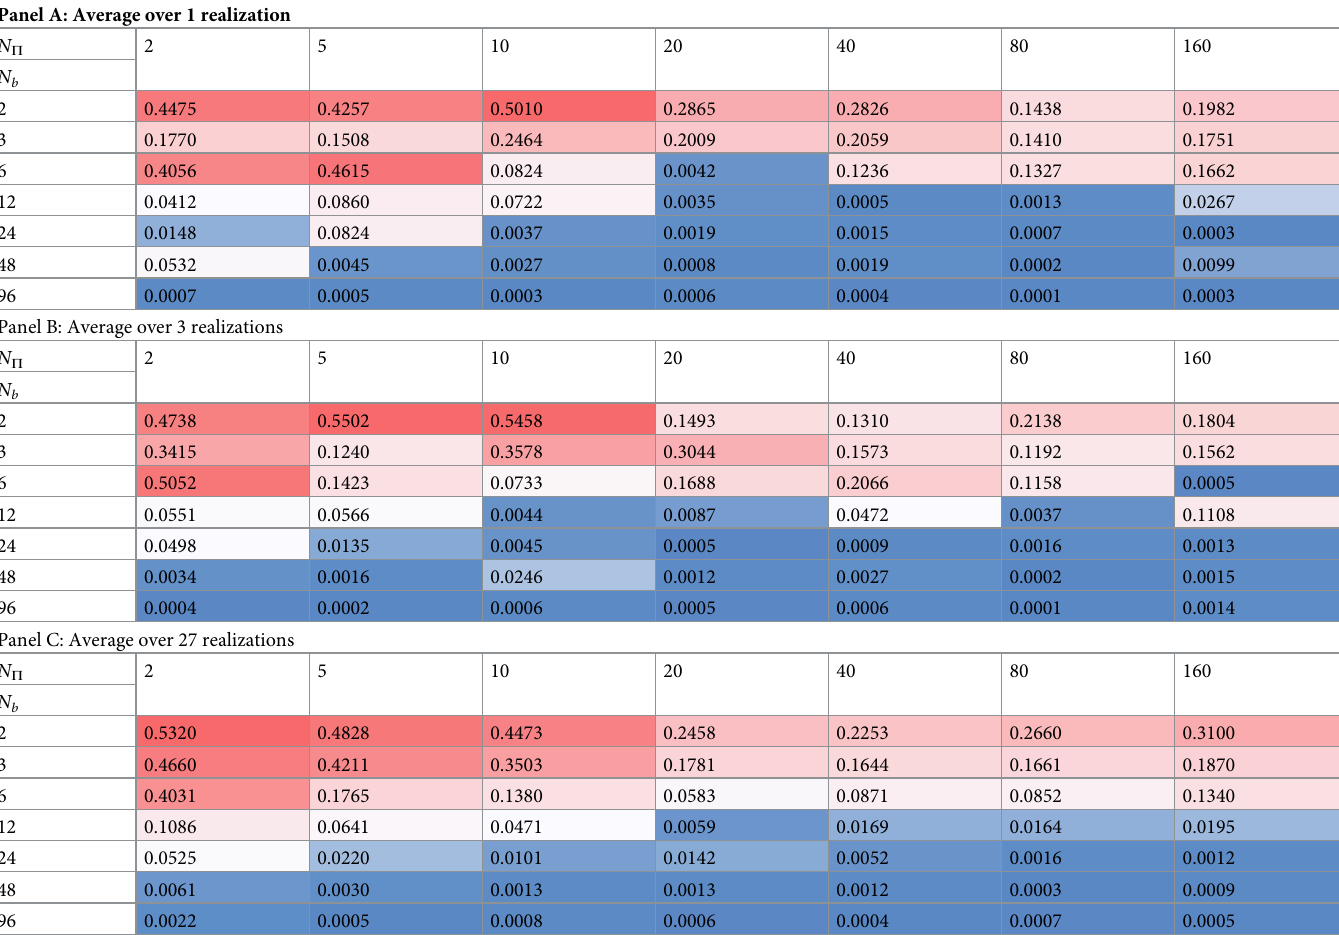
Table 5. Biot’s equations—forward modeling: PINN performance as function of training set size. Sum of relative L 2 errors between the exact and predicted values of u , v , and p for the validation set. The table shows the dependency on the number of the initial and boundary training data, N b , and on the number of collocation points, N P . The hyperparemeters are fixed to 4 layers with 10 neurons per hidden